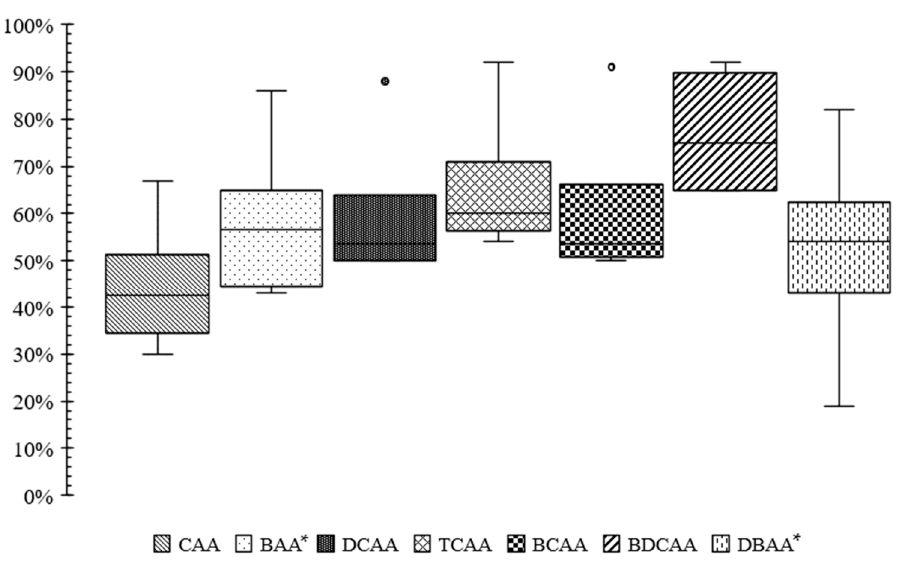
Figure 3. Percent removal of chloroacetic acid (CAA), bromoacetic acid (BAA) *, dichloroacetic acid (DCAA), trichloroacetic acid (TCAA), bromochloroacetic acid (BCAA), bromodichloroacetic acid (BDCAA), and dibromoacetic acid (DBAA) * after granular activated carbon (GAC) media filtration (n = 18 for each HAA). The box plot represents percentiles, with the center line representing the 50th percentile, the outsides of the box representing the 25th and 75th percentiles, and the lines outside of the box representing the 0th and 100th percentiles. Outliers from the data set are represented by circles outside of the boxes. * Below the limit of quantification.